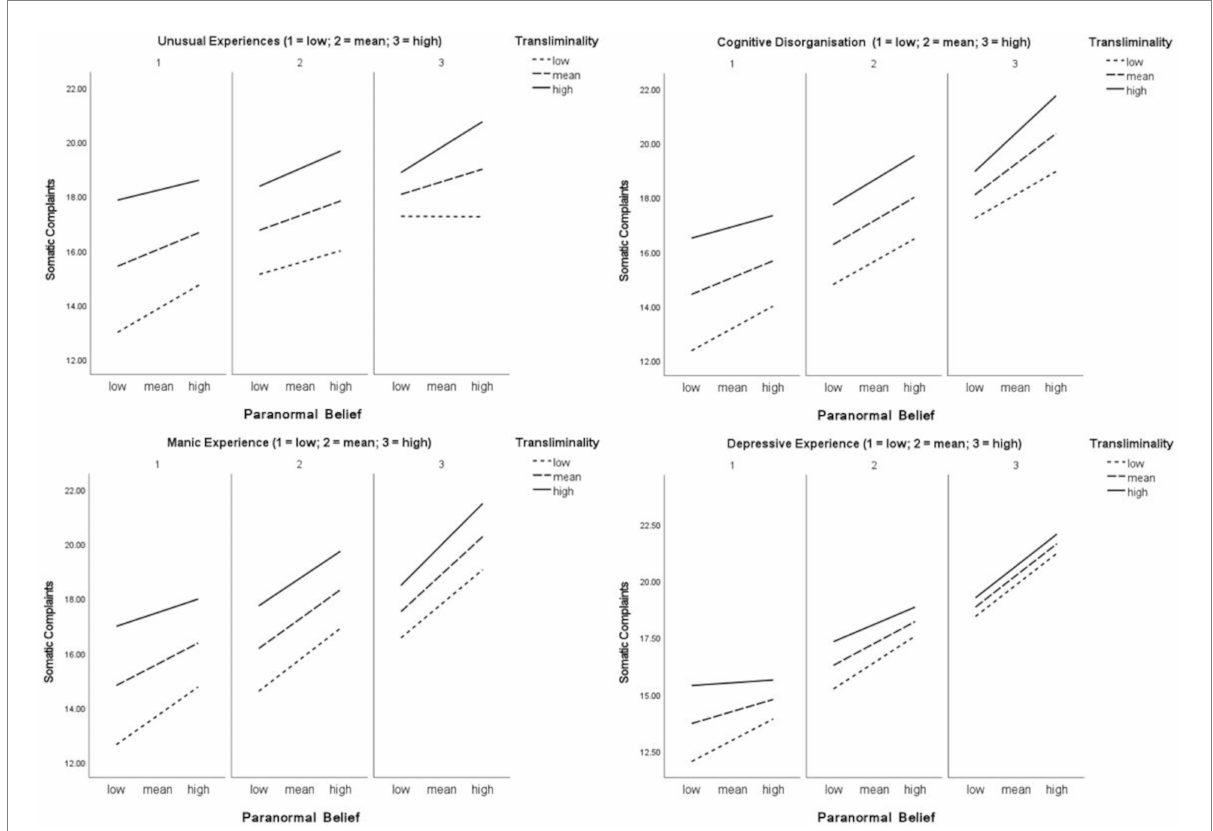
FIGURE 2 Paranormal Belief × Transliminality × psychopathology-related variables predict Somatic